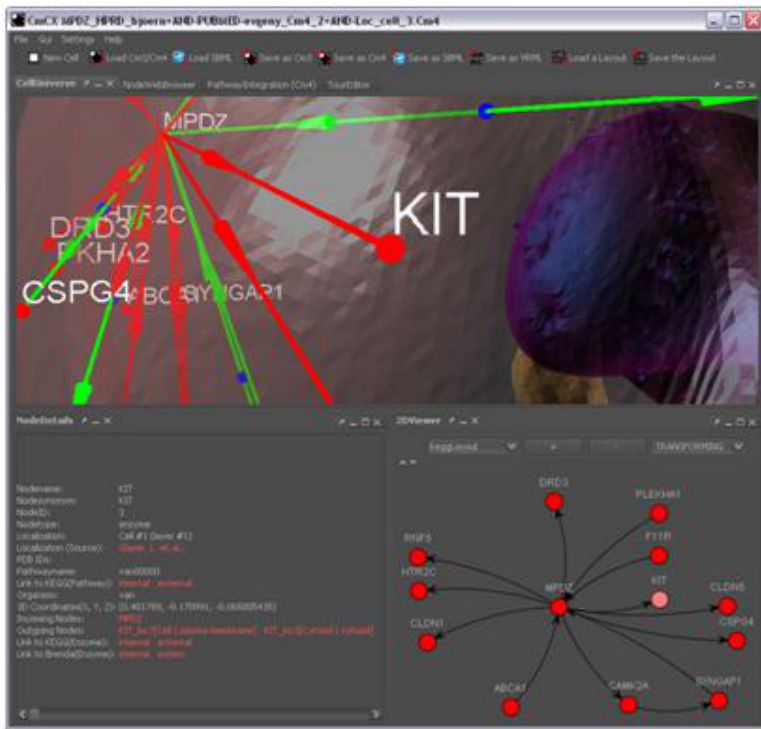
Figure 11: The comparison of the 2D and 3D visualization. In this case CmPI uses the original 2D layout from VANESA and maps it into the 3D cell environment. The NodeDetails window provides information about the actual state of the node. Every window shown here can be used for the navigation.